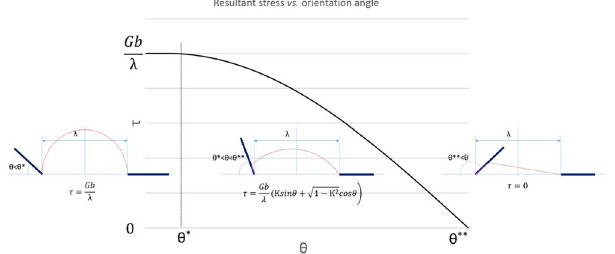
Figure 8. The resultant stress τ is monotonically decreasing because of interfacial glide. As the schematics shows no interfacial glide occurs when orientation angle θ is smaller than θ * . The stress is a function of θ when orientation angle is between θ * and θ ** . The interfacial glide will occur spontaneously when θ is larger than θ **